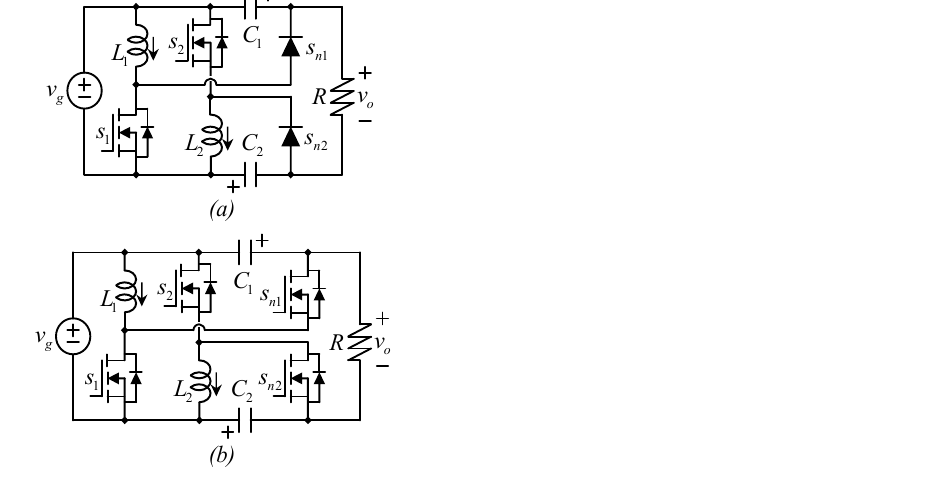
Figure 2. Proposed circuit: ( a ) unidirectional power flow and ( b ) bidirectional power flow.